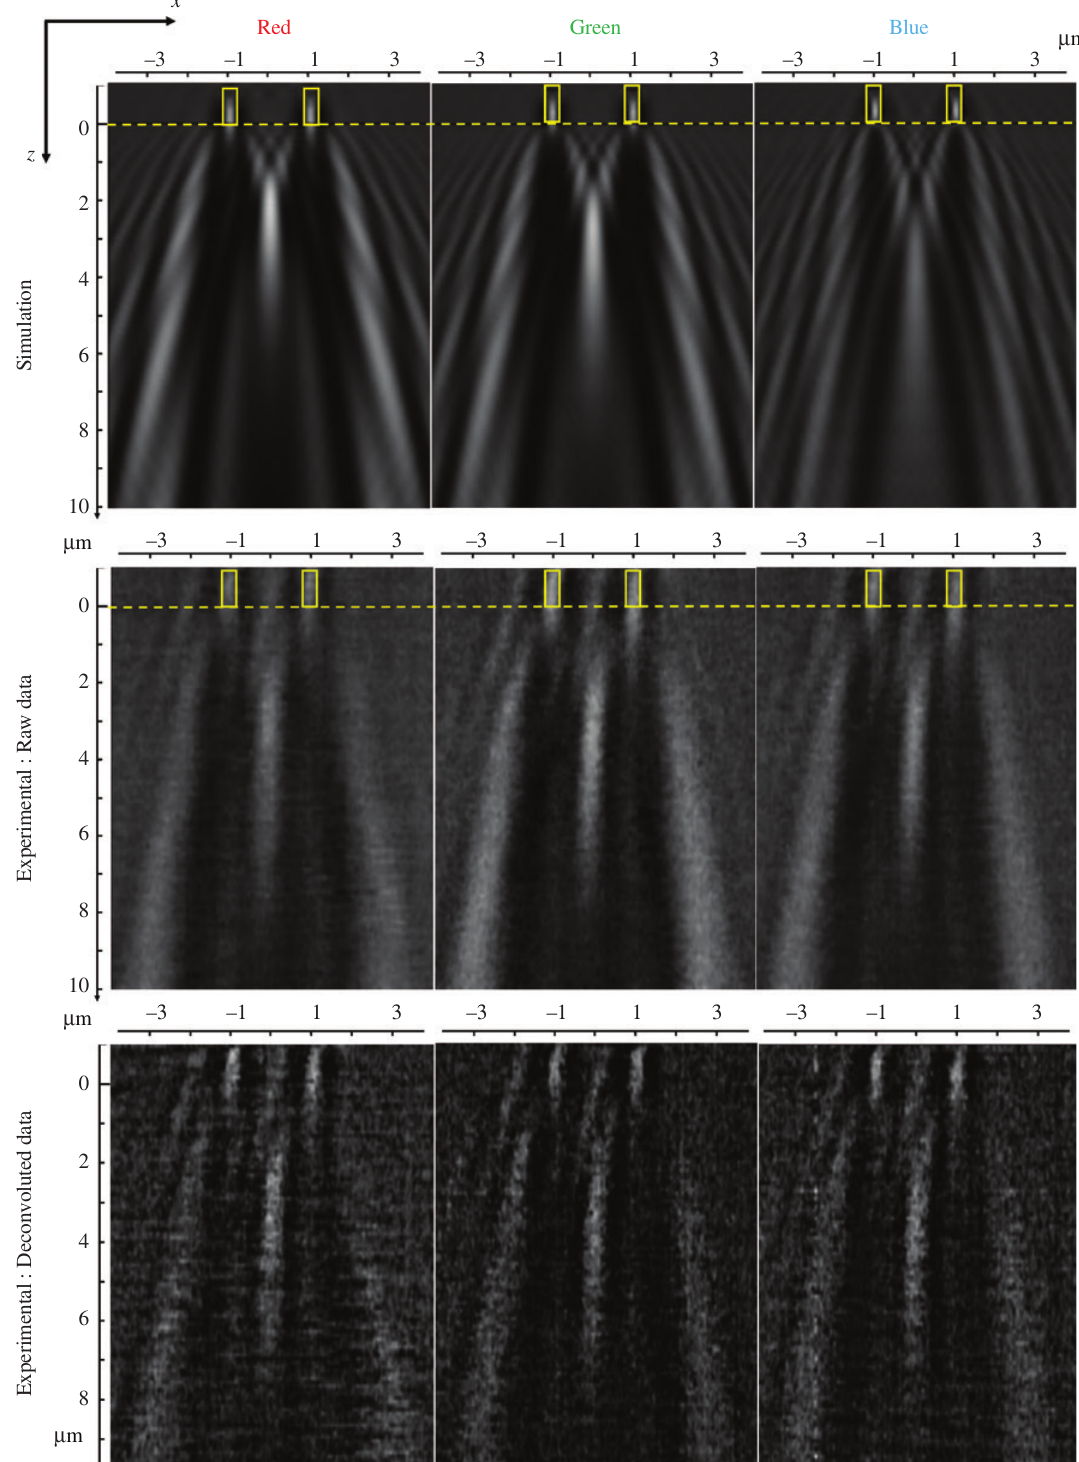
Figure 7: First row: 2D-FEM simulations of x–z diffraction intensity distributions by dielectric lines (width = 0.4 μ m, height = 0.9 μ m, n = 1.48) in a dielectric substrate (n = 1.52) for red (0.60 μ m), green (0.53 μ m), and blue (0.45 μ m) wavelengths. Second and third rows: experimental diffraction intensity distributions of polymer lines fabricated by two-photon polymerization on borosilicate substrate obtained from z-stack white light images, and after RGB color